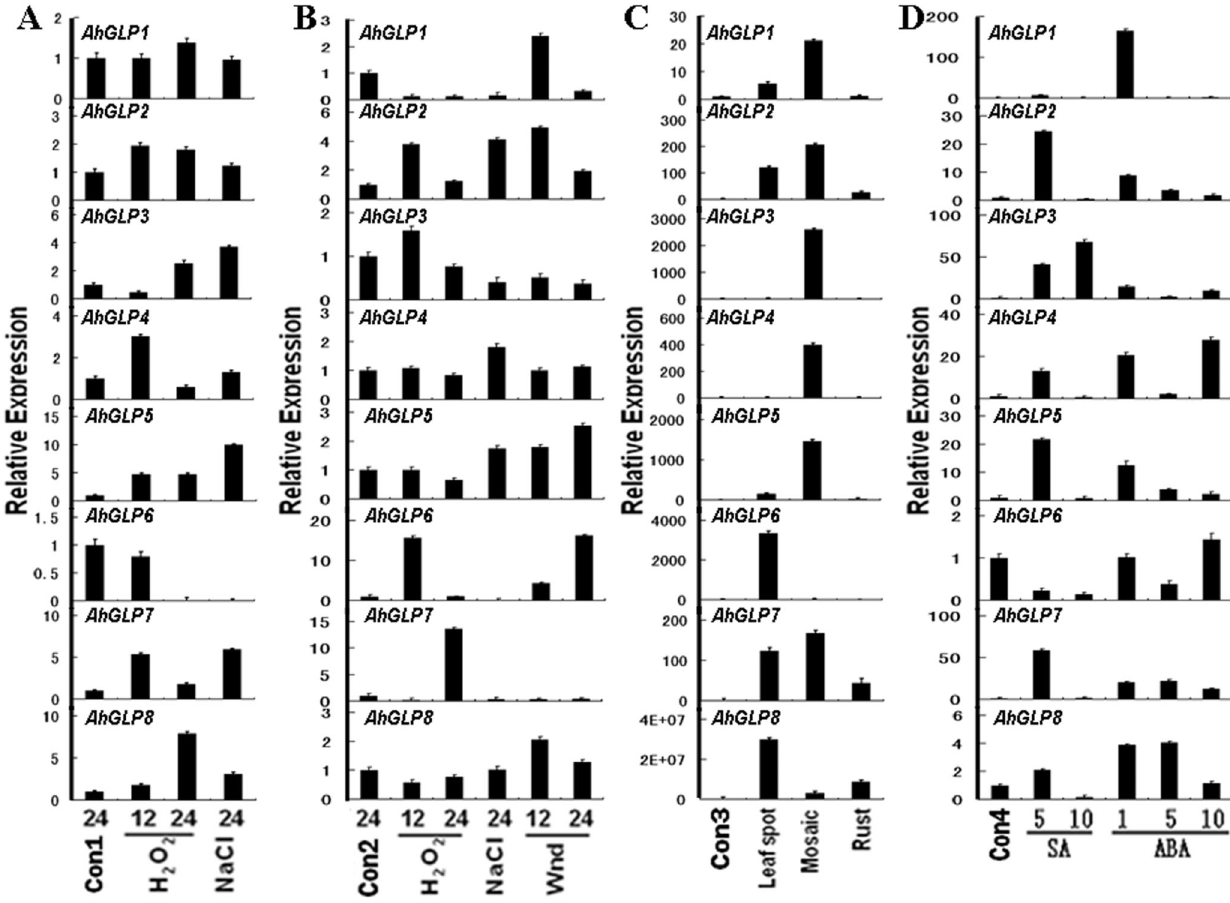
Figure 4. Differential expression of peanut AhGLP genes in response to various abiotic, biotic and hormone treatment conditions. AhGLPs transcript abundance was detected by qRT-PCR analysis. Con1 and Con2: control sample of seedling leaf and root to abiotic stresses, respectively; Con3: control of 100-day-old peanut plant leaf to biotic stresses; Con4: control of seedling leaf to hormone treatments; Wnd: wound treatment; Numbers below bars correspond to duration of treatments (h); SA: salicylic acid; ABA: abscisic acid.